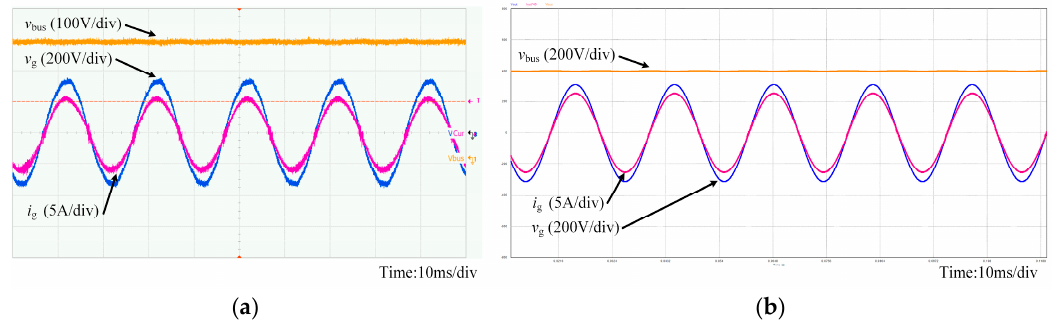
Figure 17. Experimental waveforms of the inverter at rated power: ( a ) experiment waveform; and ( b ) simulation waveform.